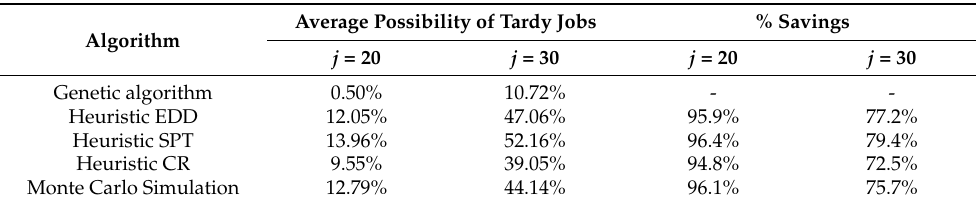
Table 6. Average possibility of tardy jobs for the GA compared to the